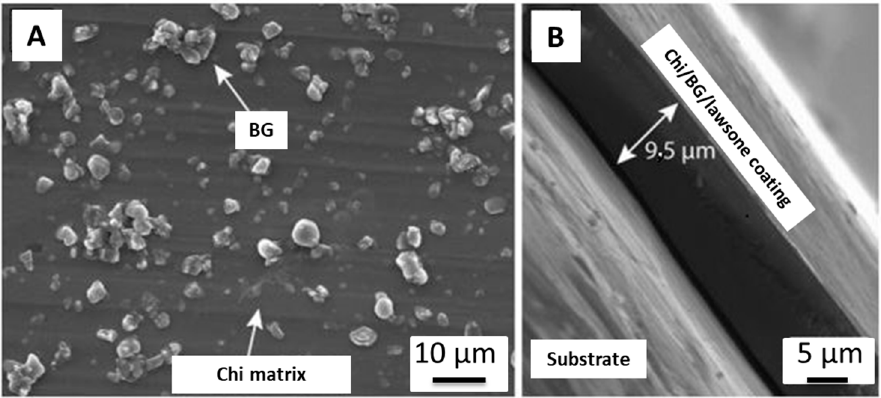
Figure 5. SEM of chi/BG/lawsone coating on SS substrate: ( A ) top view, ( B ) cross-section. Repro- duced from [74].